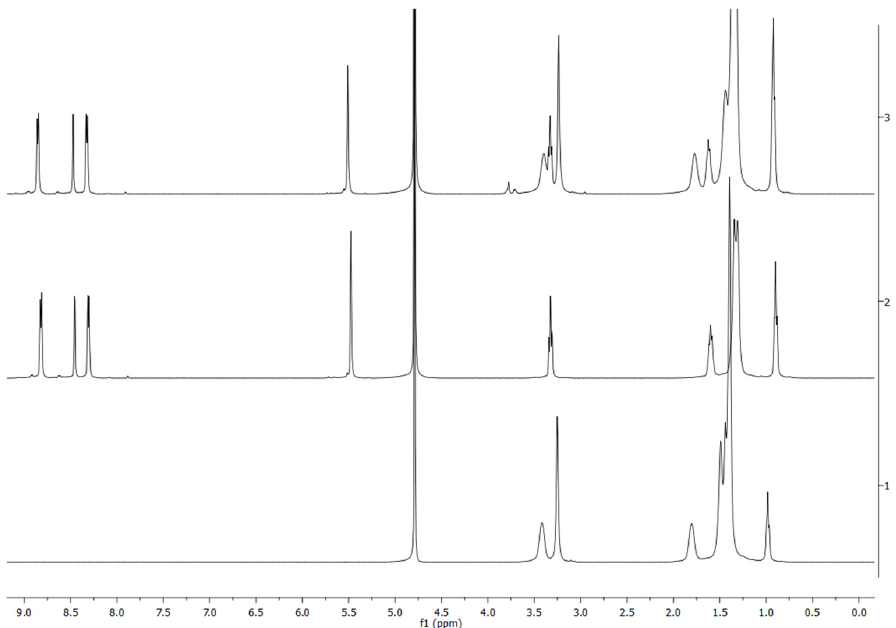
Figure 8. 1 H NMR spectra of the ( 1 ) 16-12-16, ( 2 ) IL 4-PyC8 and ( 3 ) 16-12-16:4-PyC8 in D 2 O.